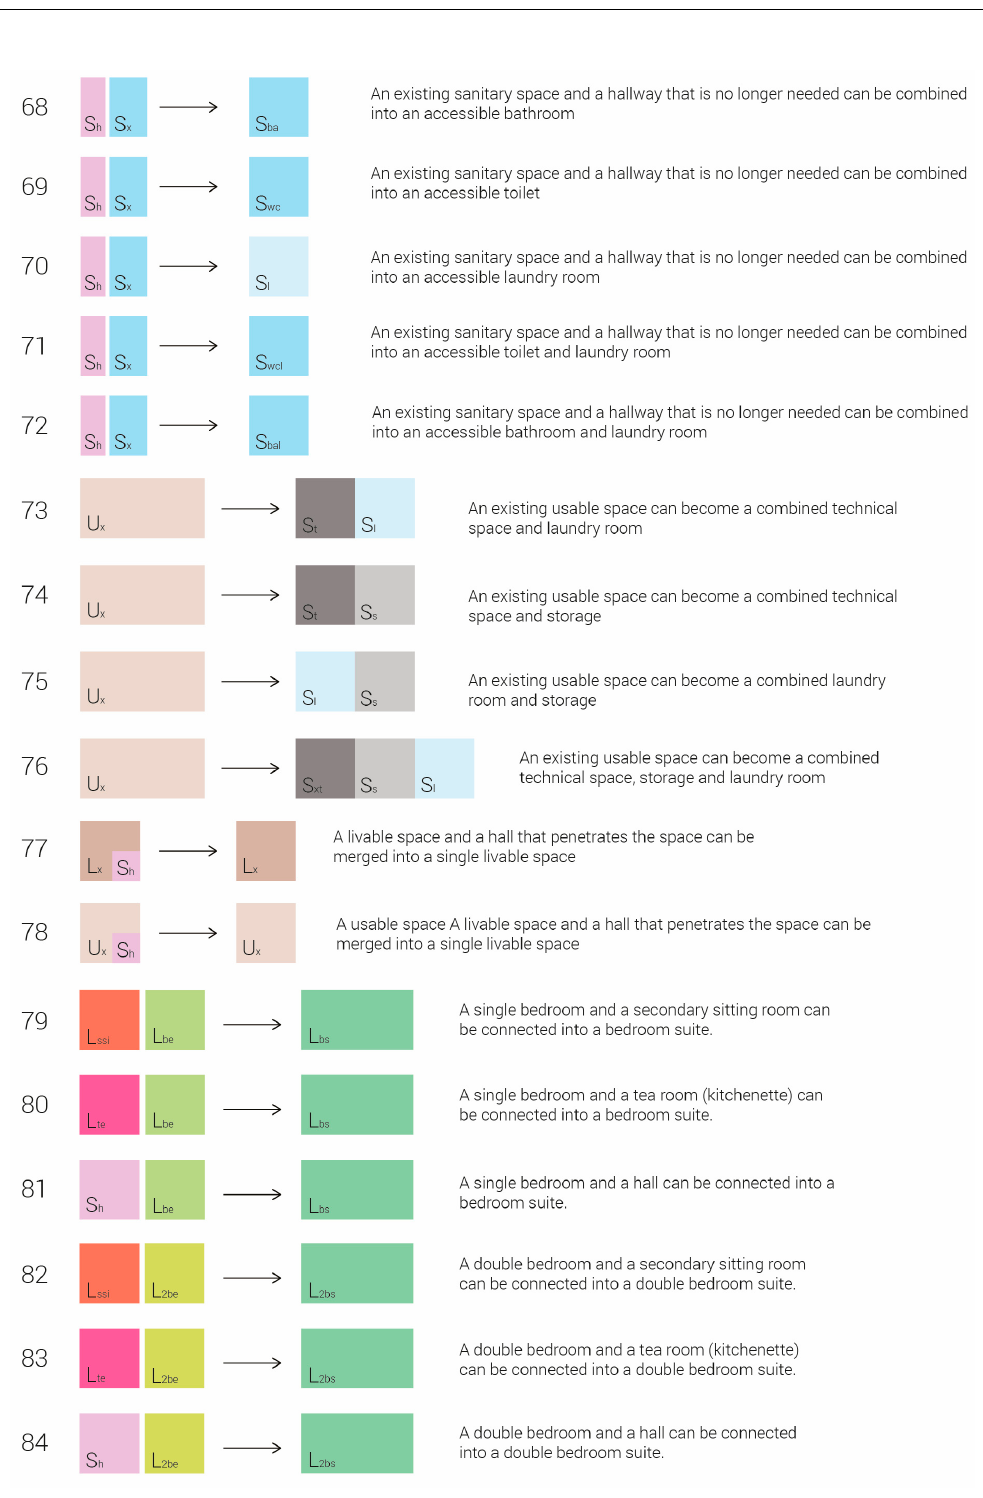
Figure 13. Transformation rules 68–84 (Ana Bel č i č , 2022).